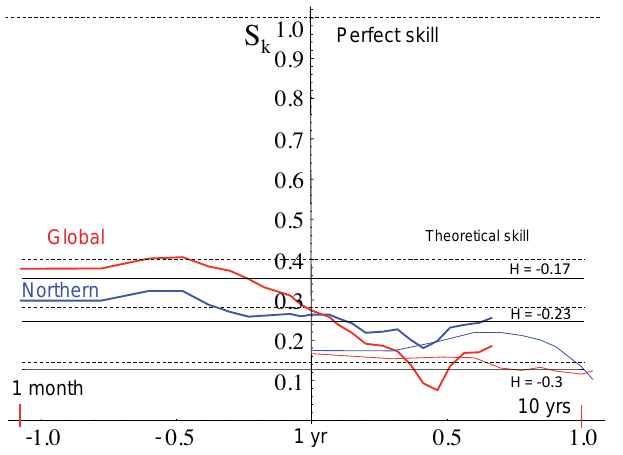
Figure 7. The anomaly forecast skill as a function of forecast hori- zon (horizontal axis) on a log-linear plot for both series (annual thin, monthly thick; global red, Northern Hemisphere blue). Also shown are pairs of theoretical predictions (constant skill independent of the forecast horizon) for various values of H . The top (dashed) member of the pair is for an infinite memory; the bottom solid line is for the finite memory used here: the monthly series has a memory of 180; the annual series has a memory of 20. This plot has no adjustable